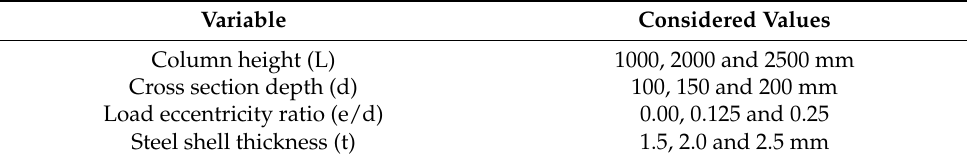
Table 3. Considered values for studied variables.